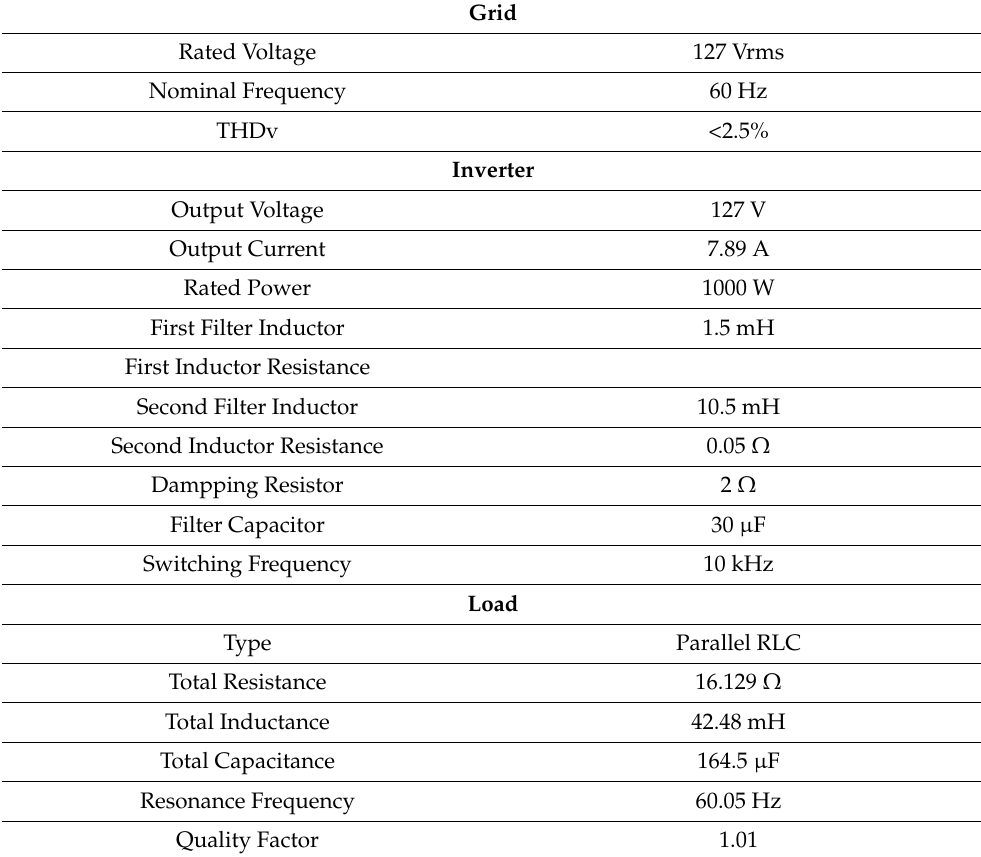
Table 1. Parameters of the experimental set-up implemented for anti-islanding test.